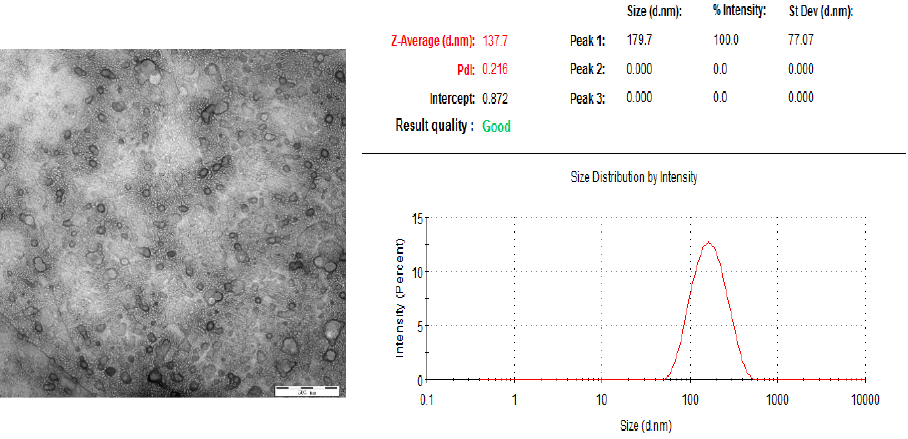
Figure 3. 3D response surface of independent variables in EE of Ori liposomes: ( a ) Effects of ultrasonic time and soybean phospholipids/drug on the EE; ( b ) Effects of soybean phospholipids/drug and temperature of water bath on the EE; ( c ) Effects of soybean phospholipids/drug and temperature of water bath on the EE.